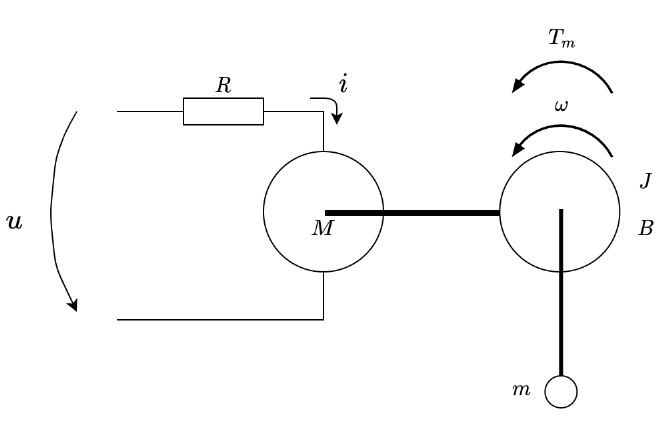
Figure 10. Rigid joint conceptual